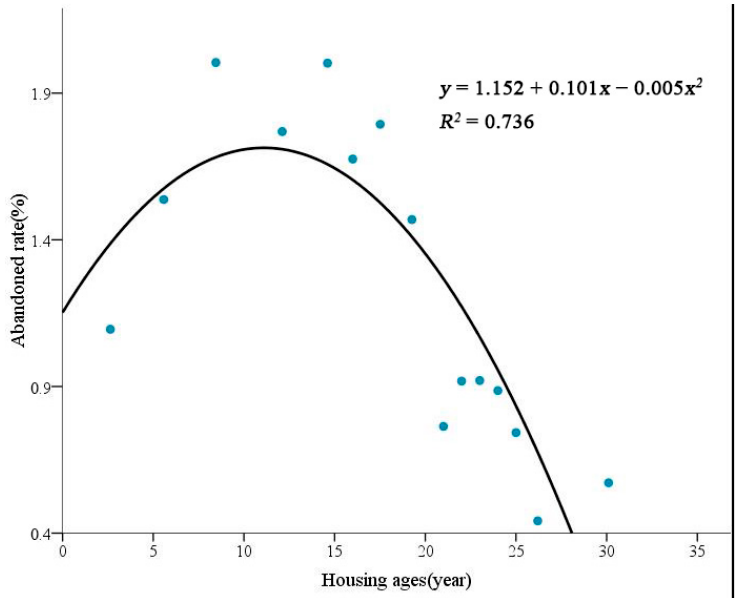
Figure 8. Fitting curve of housing ages and abandonment rate.